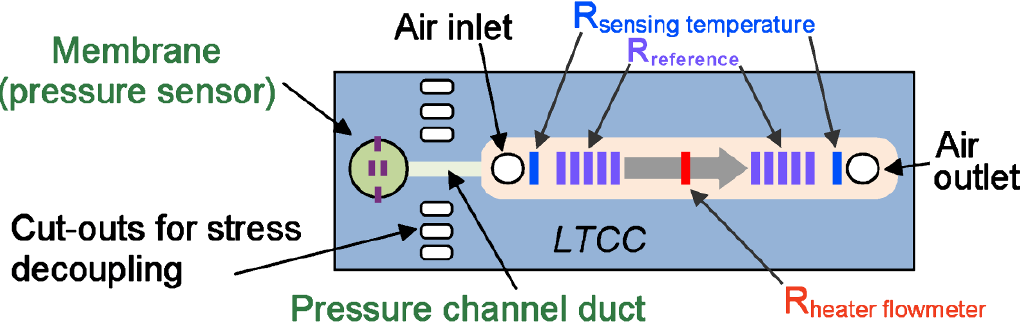
Figure 4. Schematic top view of the integrated sensor, showing the placement of the fluidic functions and the elongated shape of the